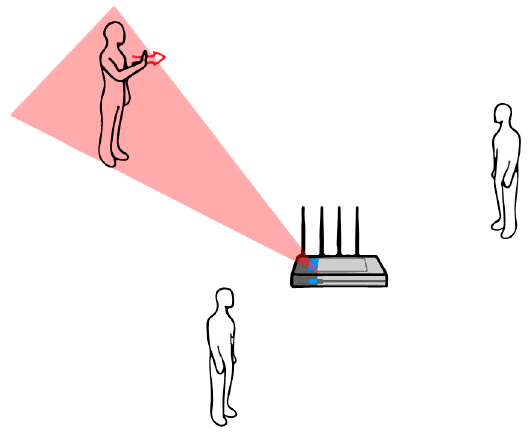
Figure 6. WFI recognition of different hand positions.